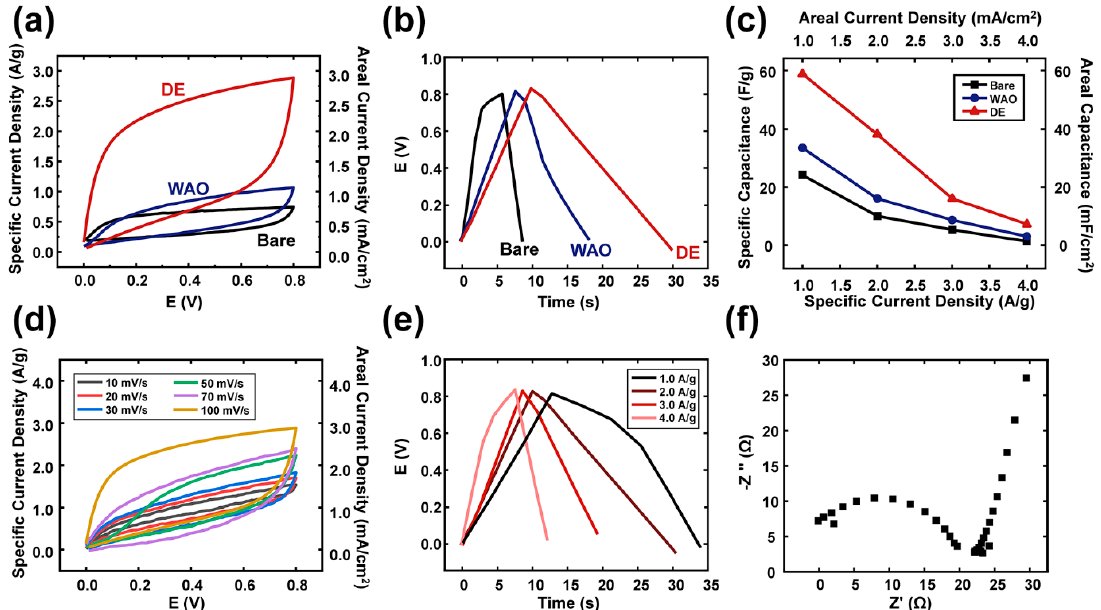
Figure 3. The electrochemical tests of each electrode via the three-electrode system. ( a ) The CV plots; ( b ) the galvanostatic charge-discharge (GCD) plots; and ( c ) the calculated specific/areal capacitance values. Additionally, the detailed electrochemical results for DE. ( d ) The CV plots under various scan rates; ( e ) the GCD curves with different applied current densities; and ( f ) the EIS curve of DE.